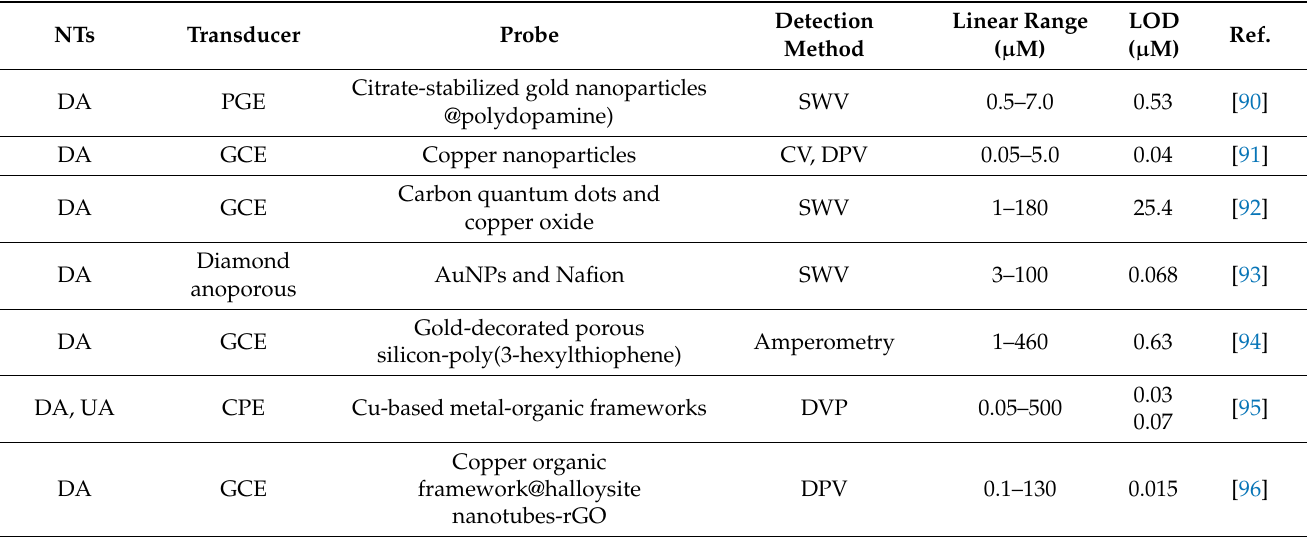
Table 2. Comparison of electrochemical catecholamines sensor based on metal and metal oxide